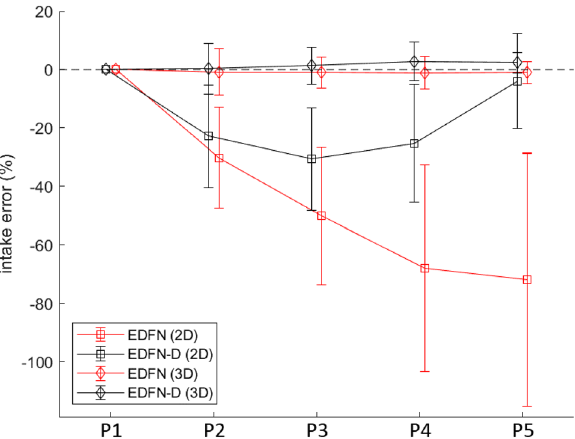
Figure 4. Intake accuracy of our proposed method without (EDFN, red) and with (EDFN-D, black) depth- refinement on the modified texture foods dataset. 2D refers to two-dimensional % intake error in terms of the proportion of pixels estimated compared to the ground-truth hand segmentation of food areas. 3D refers to three-dimensional % intake error in terms of the relative volume across the estimated food segment compared to the volume across the ground-truth segmentation of food areas. Here, P1 is the reference plate with P2-P5 representing simulated degrees of increasing intake (i.e., P5 most eaten).